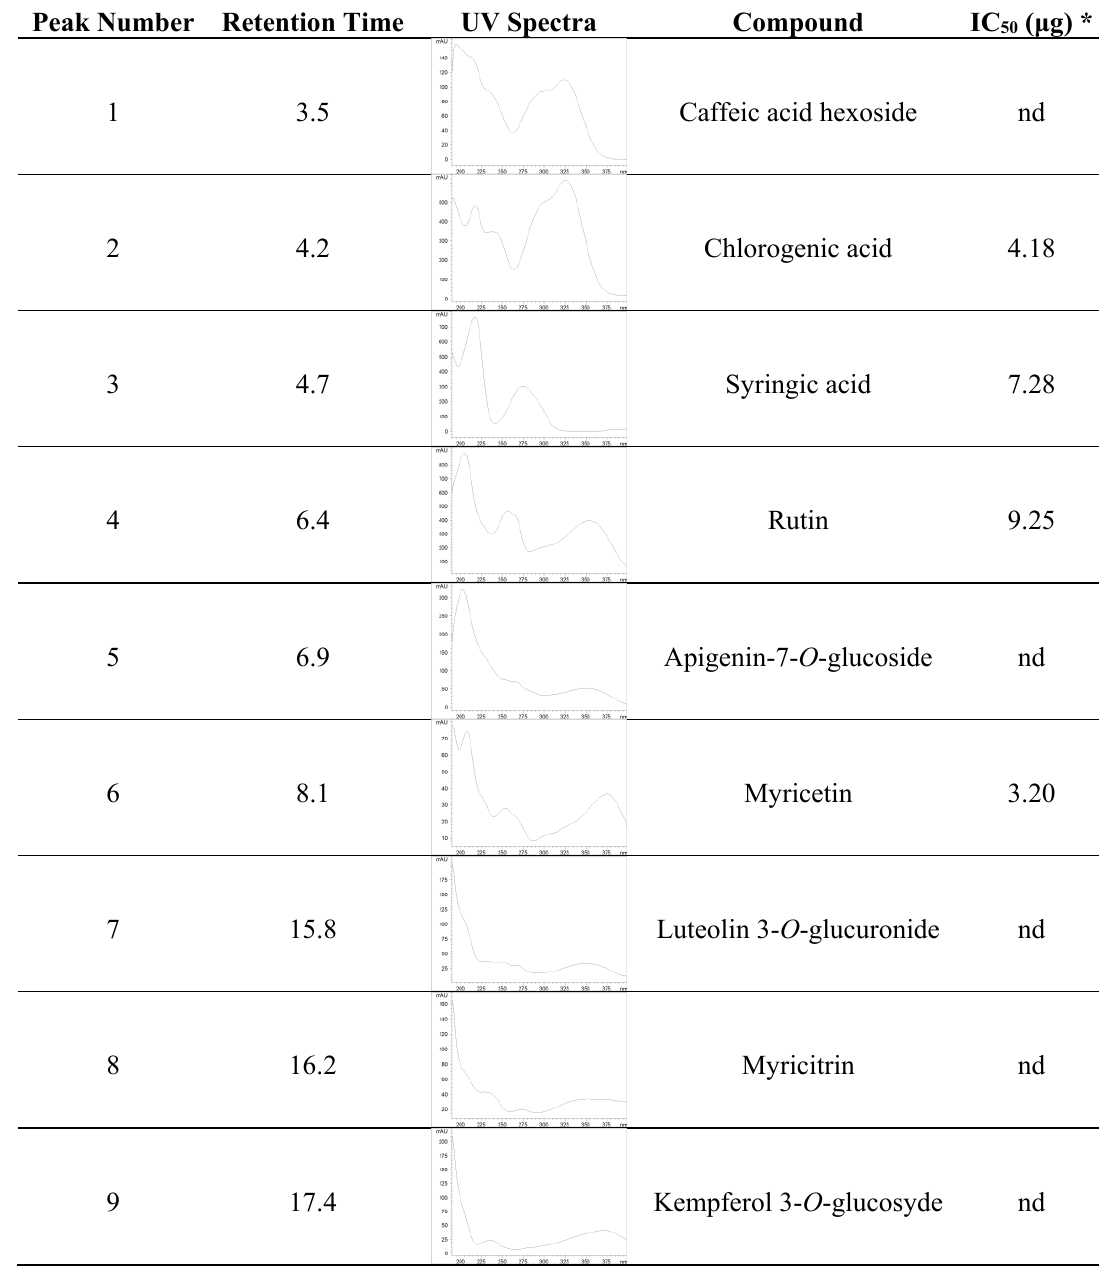
Table 1. Main phenolic compounds identified in blueberry extracts by HPLC and LC-MS/MS. The numbers correspond to peaks in Figure 5 and structures of Figure